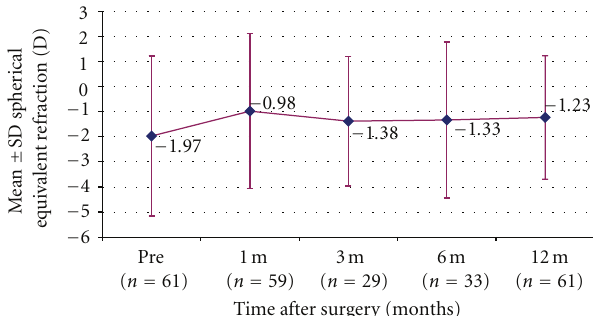
Figure 5: Stability of SE after epithelium-on CXL.